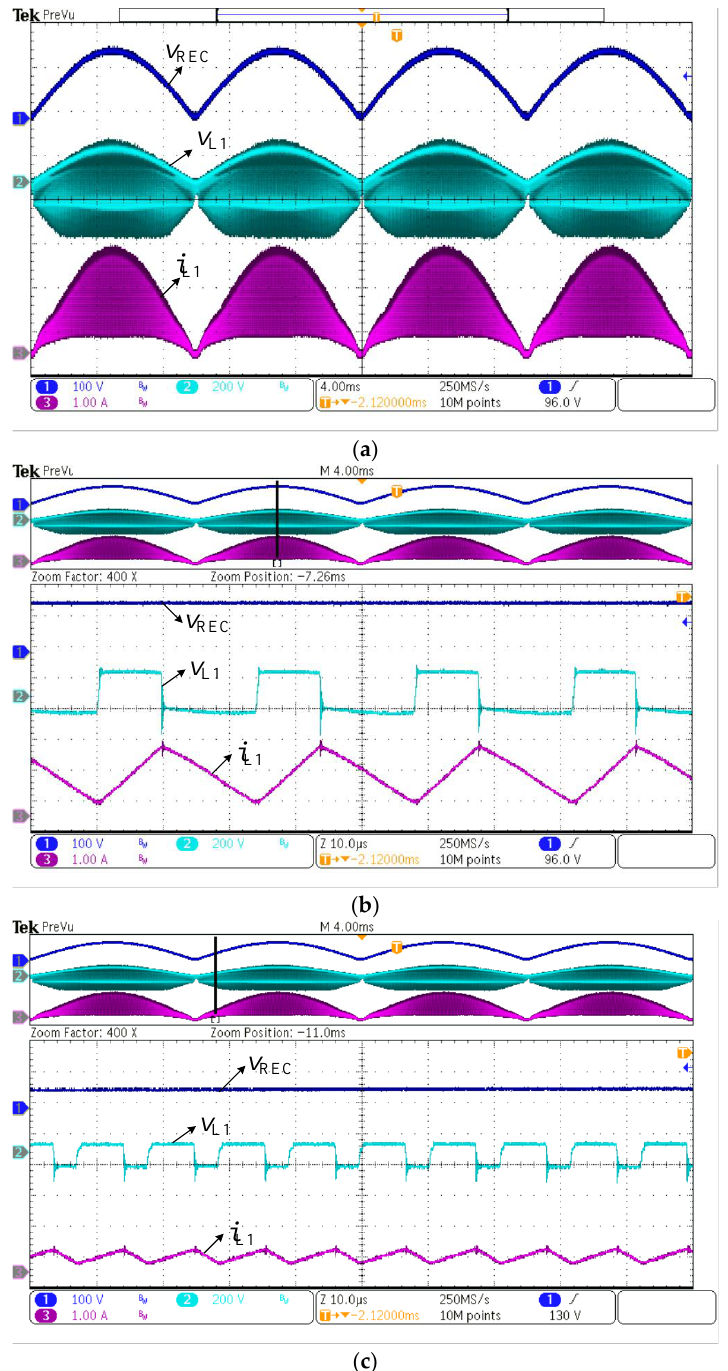
Figure 23. Experimental waveforms of v REC , v L 1 , and i L 1 of VOT control with 110 Vac input voltage and rated current load. ( a ) overall waveform; ( b ) zoomed-in waveform at ω t = π /2, i.e., v Rec is 155 V; ( c ) zoomed-in waveform around zero-cross point of input voltage, v Rec is 50